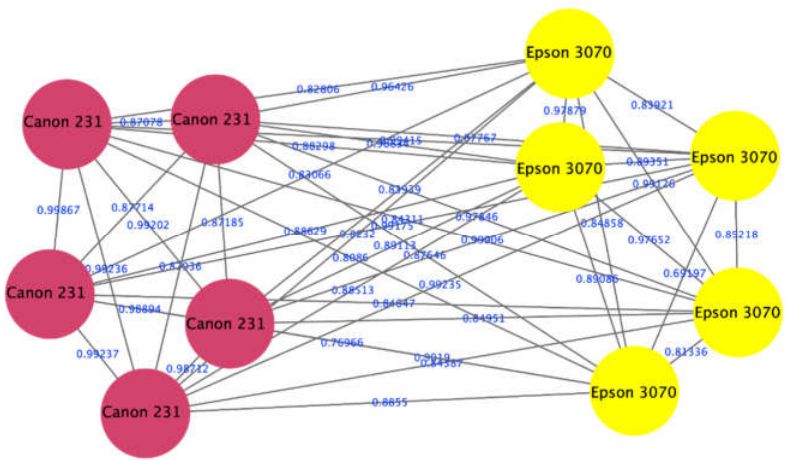
Figure 7. Visualization of spectra from a laser printer Canon 231 appeared in a laser printers cluster (red nodes), and spectra from an inkjet printer Epson 3070 appeared in an inkjet printers cluster (yellow nodes).